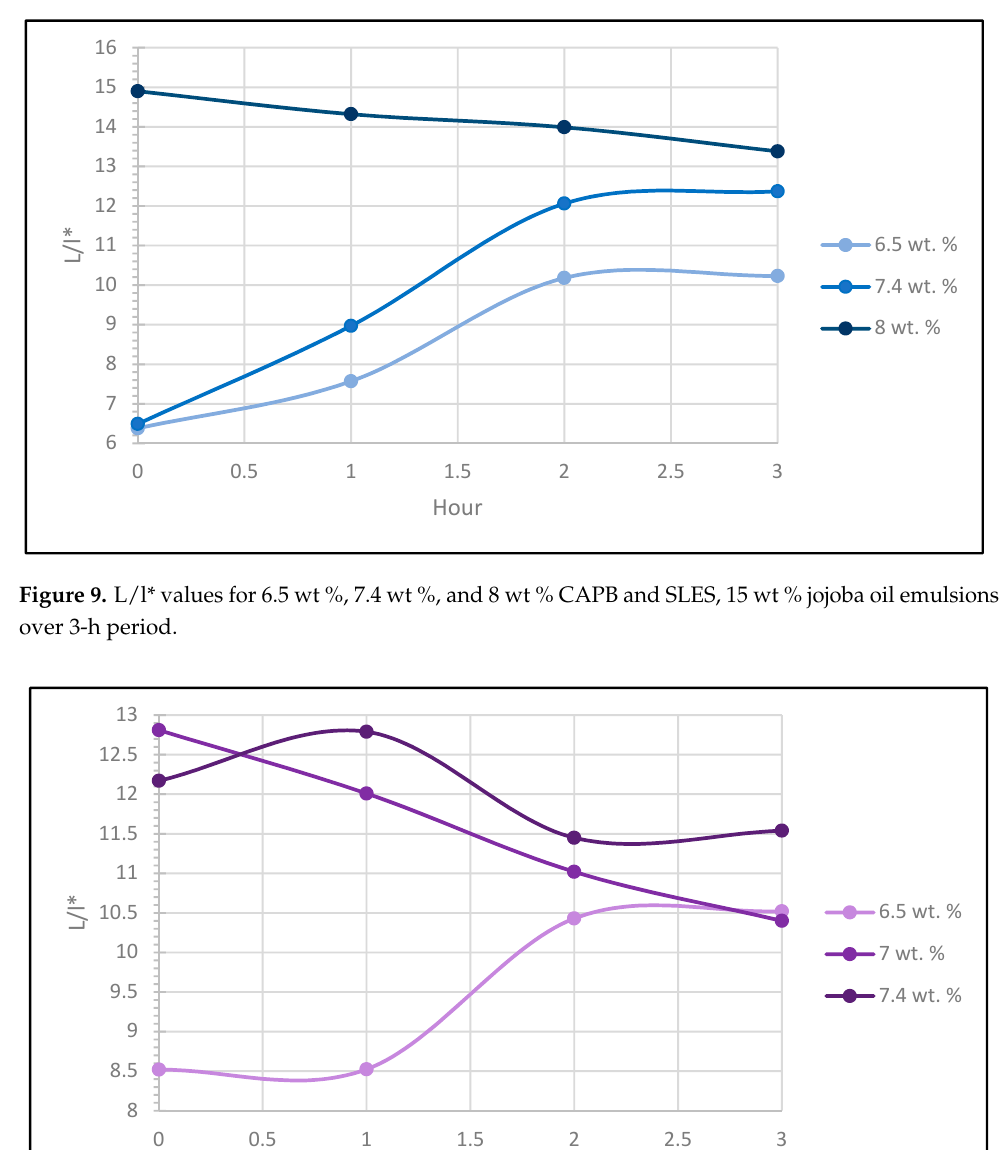
Figure 9. L/l* values for 6.5 wt %, 7.4 wt %, and 8 wt % CAPB and SLES, 15 wt % jojoba oil emulsions over 3 ‐ h period.